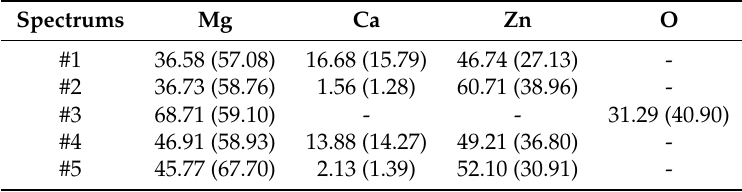
Figure 1. Optical microscope (OM) images ( a , b ) and SEM images ( c , d ) of homogenized MZC ( a,c ) and MZCM ( b,d ). Table 2. Chemical composition of MZC and MZCM by EDS, wt% (at.%). Table 2. Chemical composition of MZC and MZCM by EDS, wt% (at.%).